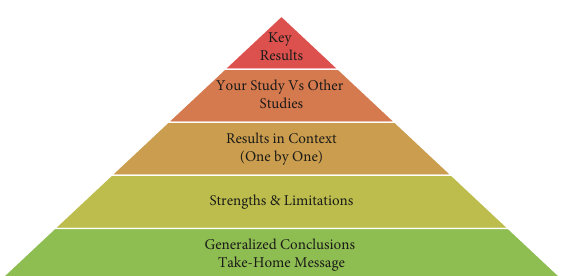
Figure 9: Pyramid scheme followed while writing the discussion section of manuscript, moving from the key results of the study to the specific conclusions.